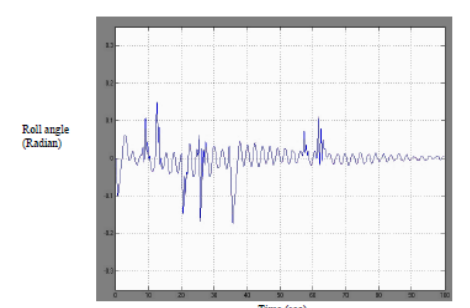
Figure 7. Filtered Roll angle measurement with a 8th order Butterworth low pass filter with 10 Hz bandwidth 5 GROUND CONTROL STATION